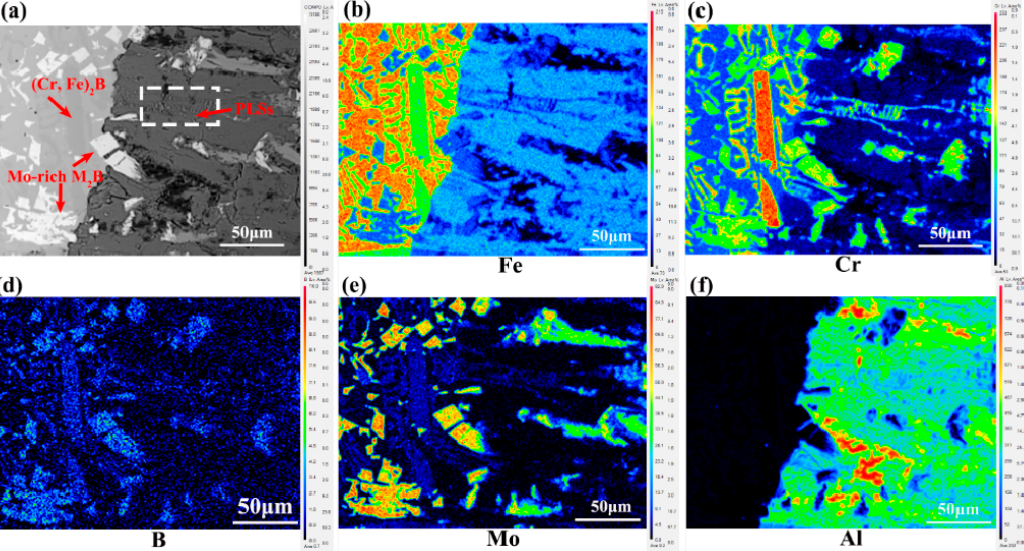
Figure 11. Elemental X-ray mapping distribution of alloy M4 after corrosion test for 8 h at 750 °C: ( a ) interfacial corrosion layer morphology; ( b ) Fe; ( c ) Cr; ( d ) B; ( e ) Mo; ( f ) Al.